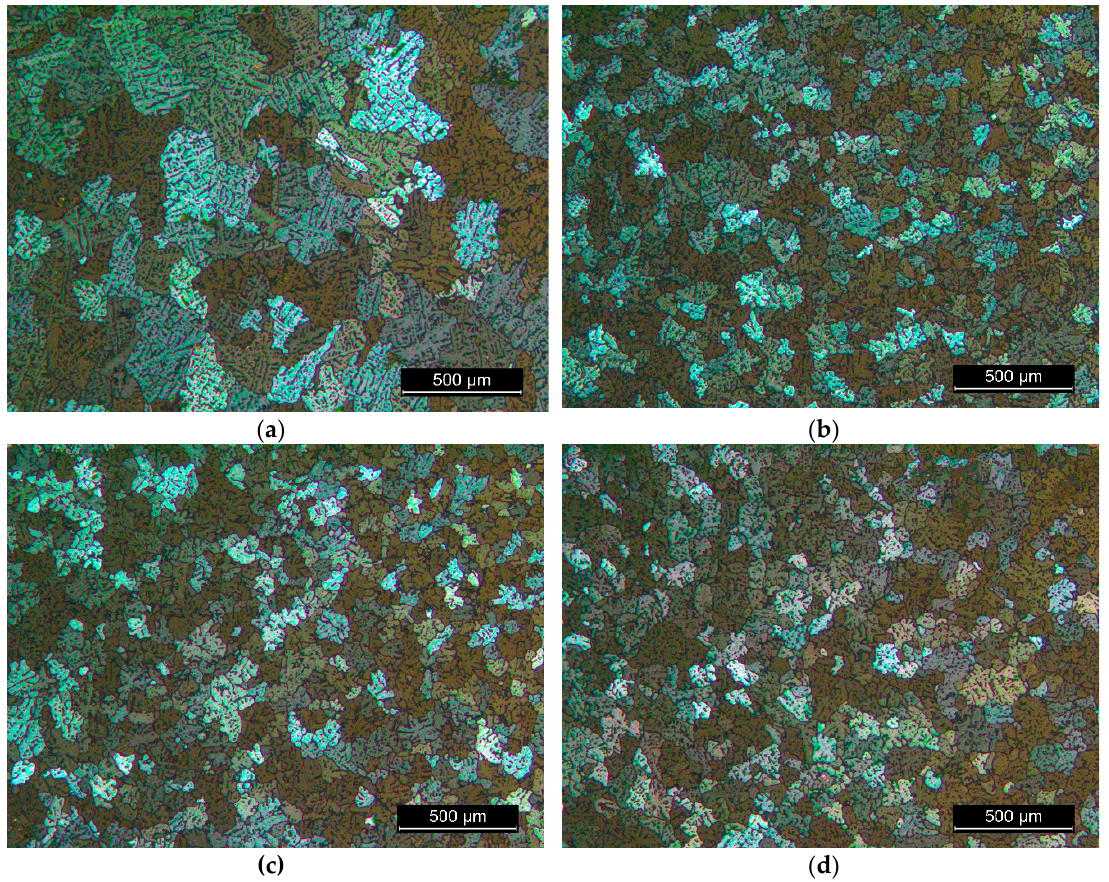
Figure 14. Microstructure of the anodized samples for grain size evaluation ( a ) manual stirred samples from batch 45M; USV treaded ones of ( b ) batch 15U, ( c ) batch 45U, and ( d ) batch 90U (taken near the edge of the samples).